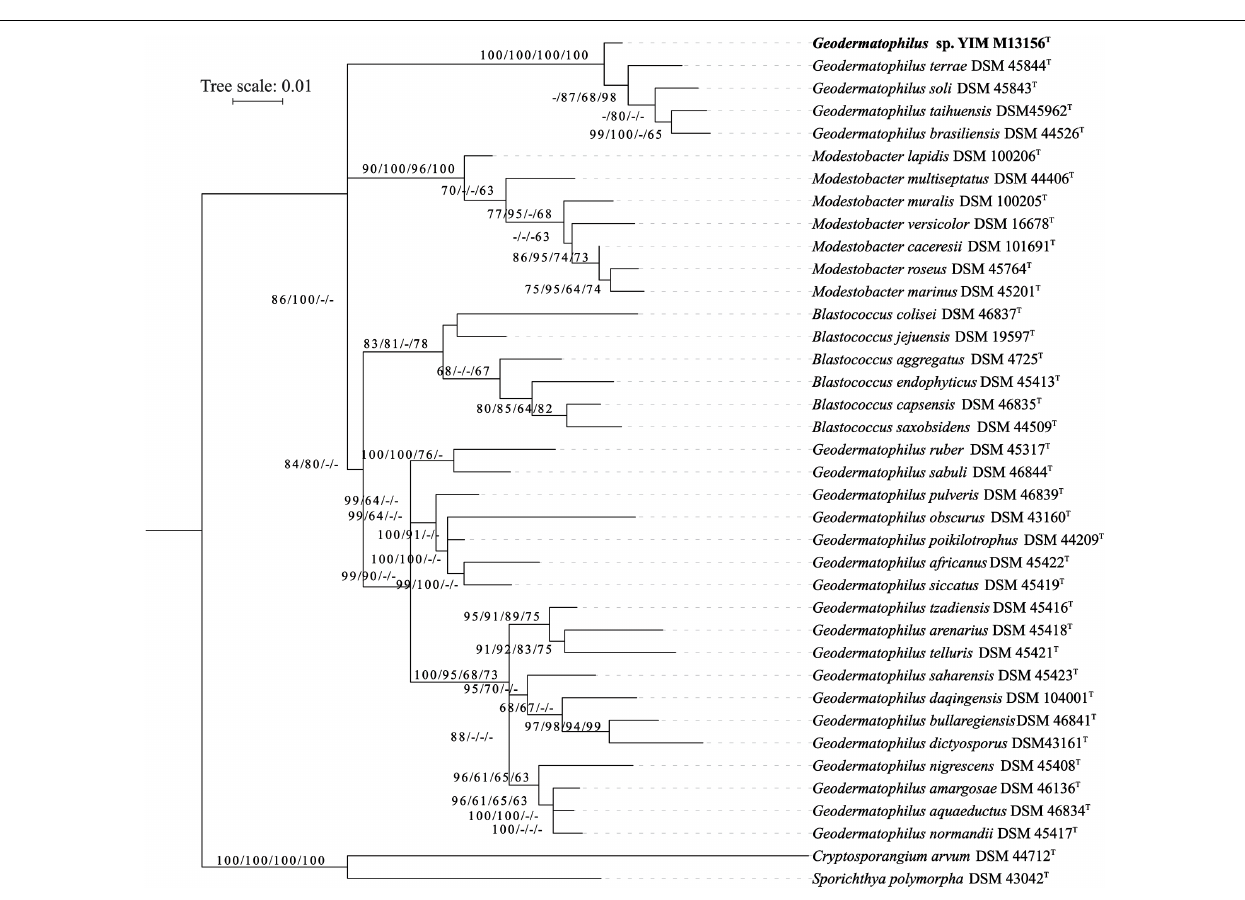
Frontiers in Microbiology |